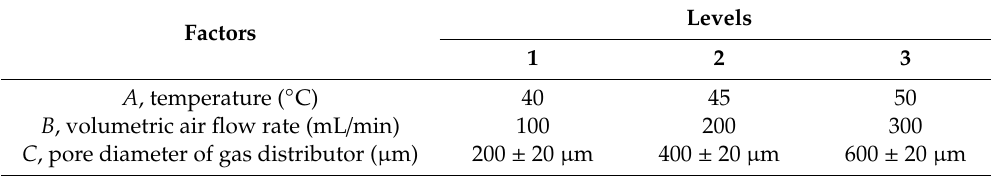
Table 7. Factors and levels of the orthogonal test for the second-stage foam fractionation. Factors